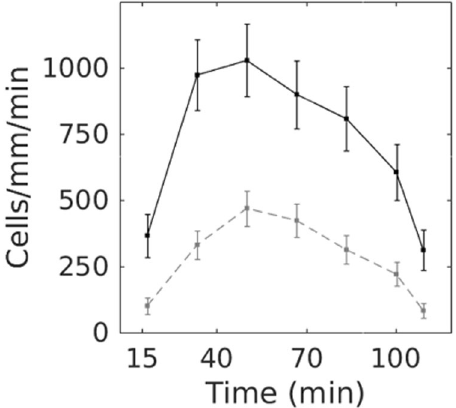
Figure 8. Neutrophil penetration rate into the under-agarose space. The number of cells exiting the well was determined at different time points and normalized by wall width and time interval. Black and gray (dotted) curves depict cells located on a homogenous saturated formyl peptide pattern (n = 272) and on 20% of saturation pattern (n = 211), respectively. Neutrophils exited the well at a higher rate when located on a pattern with high formyl peptide concentration (P = 6.2 × 10 − 16 , χ 2 test). Values represent the mean ± SD. Results are representative for 3 independent